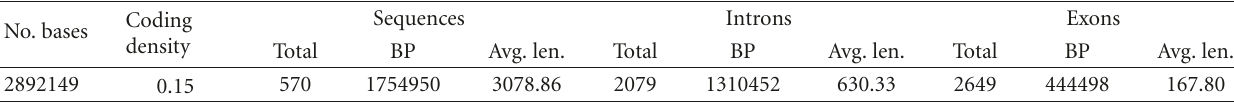
Table 1: Properties of the ALLSEQ dataset.